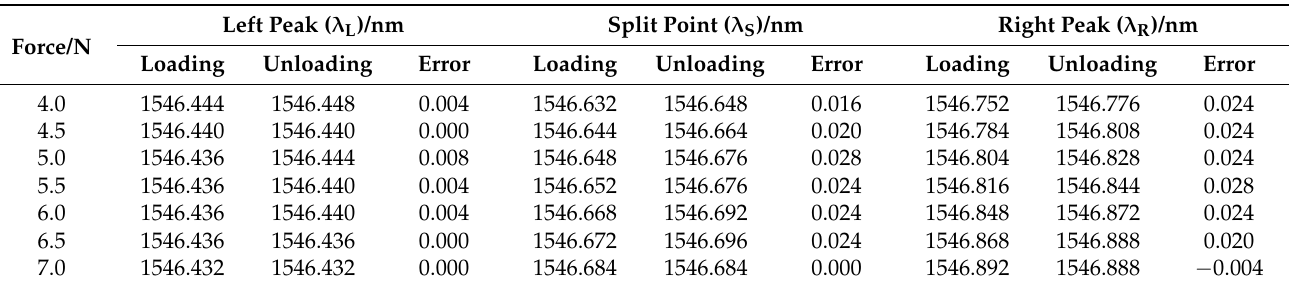
Table 1. Experimental results of local lateral forces and left peak, split point, and right peak wave- lengths for the FBG.